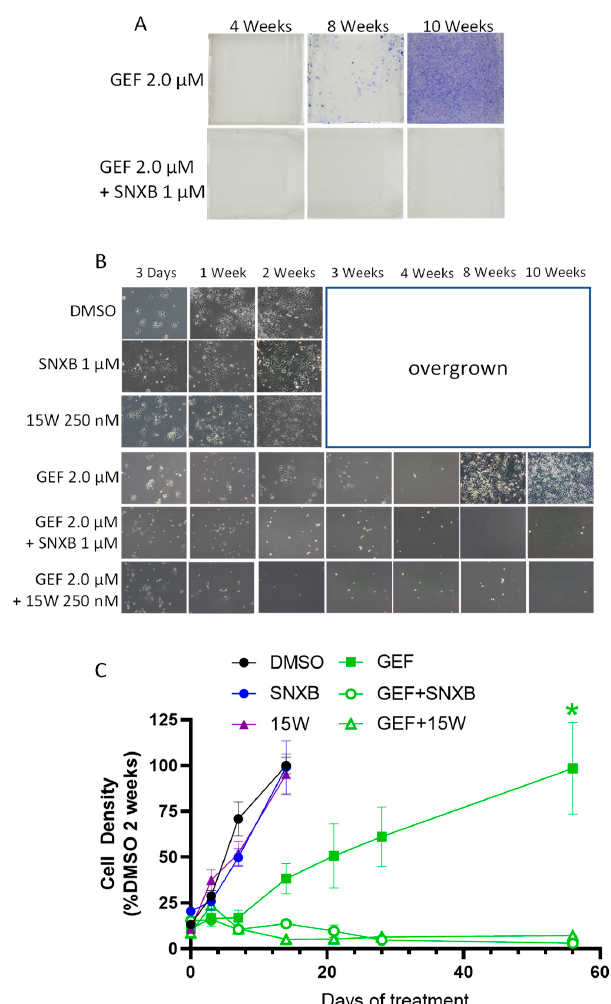
Figure 2. CDK8/19 inhibitors senexin B (SNXB) and 15w prevent resistance to EGFR inhibitor gefitinib (GEF) in SKBR3 breast cancer cells. ( A ). Representative photographs showing cell density (crystal violet staining) in flasks at 4, 8 and 10 weeks of treatment. ( B ). Representative phase-contrast microphotographs at 3 days, and at 1, 2, 3, 4, 8 and 10 weeks of treatment. ( C ). Densitometric measurements of photomicrographs expressed as percentage of cell density in DMSO controls at 2 weeks. Data shown as mean ( n = 4 images/flask) ± SEM. p < 0.0001 for GEF vs. GEF+SNXB/15w ( * ) at 8 weeks.